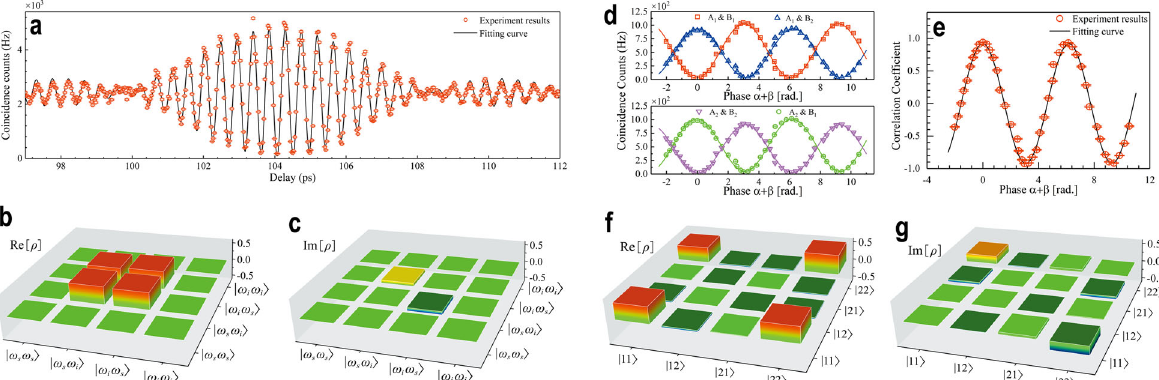
Fig. 4 Results of frequency-bin and time-bin entangled photon-pairs. a Spatial quantum beating of frequency-bin entangled state. b , c The real and the imaginary parts of the experimentally reconstructed density matrix of frequency-bin entangled photon-pairs, respectively. d The phase α + β dependence of the threefold coincidence between the synchronous electrical signal and the photons from the ports A 1 &B 1 (red rectangle), A 1 &B 2 (blue triangle), A 2 &B 1 (purple inverted triangle), or A 2 &B 2 (green circle). e Correlation coef fi cient E ( α , β ) calculated from the four curves in d according to Eq. (2). f , g The real and the imaginary parts of the density matrix of time-bin entangled photon-pairs, respectively. The error bars in a and d are all estimated from measurement results assuming Poissonian statistics, while the error bars in e are obtained via propagation of statistical errors according to Eq. Fig. 3d and has a visibility of 98.10 ± 0.01%. It is obvious that the period of the oscillation of coincidence between signal and idler photons is half that of the observed single-photon interference.